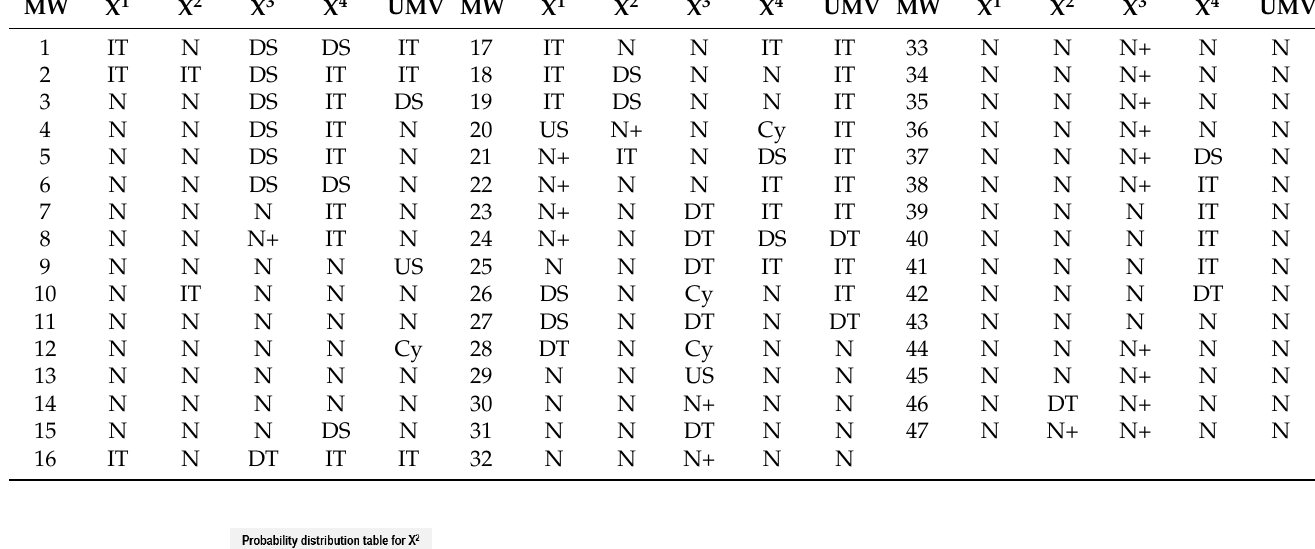
Probability Table. The Conditional Probability Table shows the probability that an event (pattern) occurs in said variable. The probabilities that are not shown in the Conditional Probability Table are due to the fact that they have an insignificant representation < 0.15. The Conditional Probability Table associated with the response or resultant node shows the total probabilities of the Bayesian Inference that identifies the probability that a pattern with special variation will be present in the UMV . Table 2. Patterns found in the variables and a global summary of cases found.